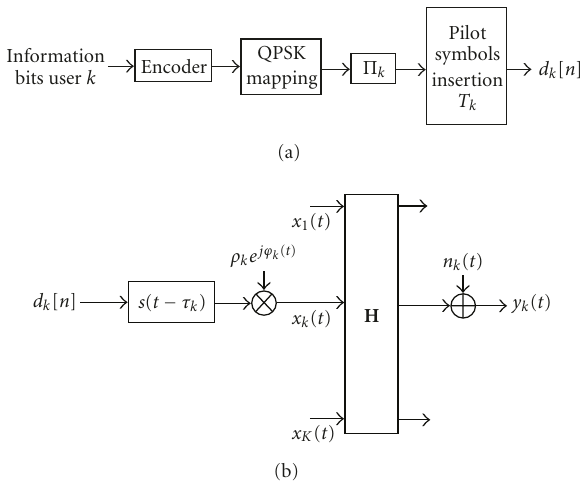
Figure 1: Transmitter and channel